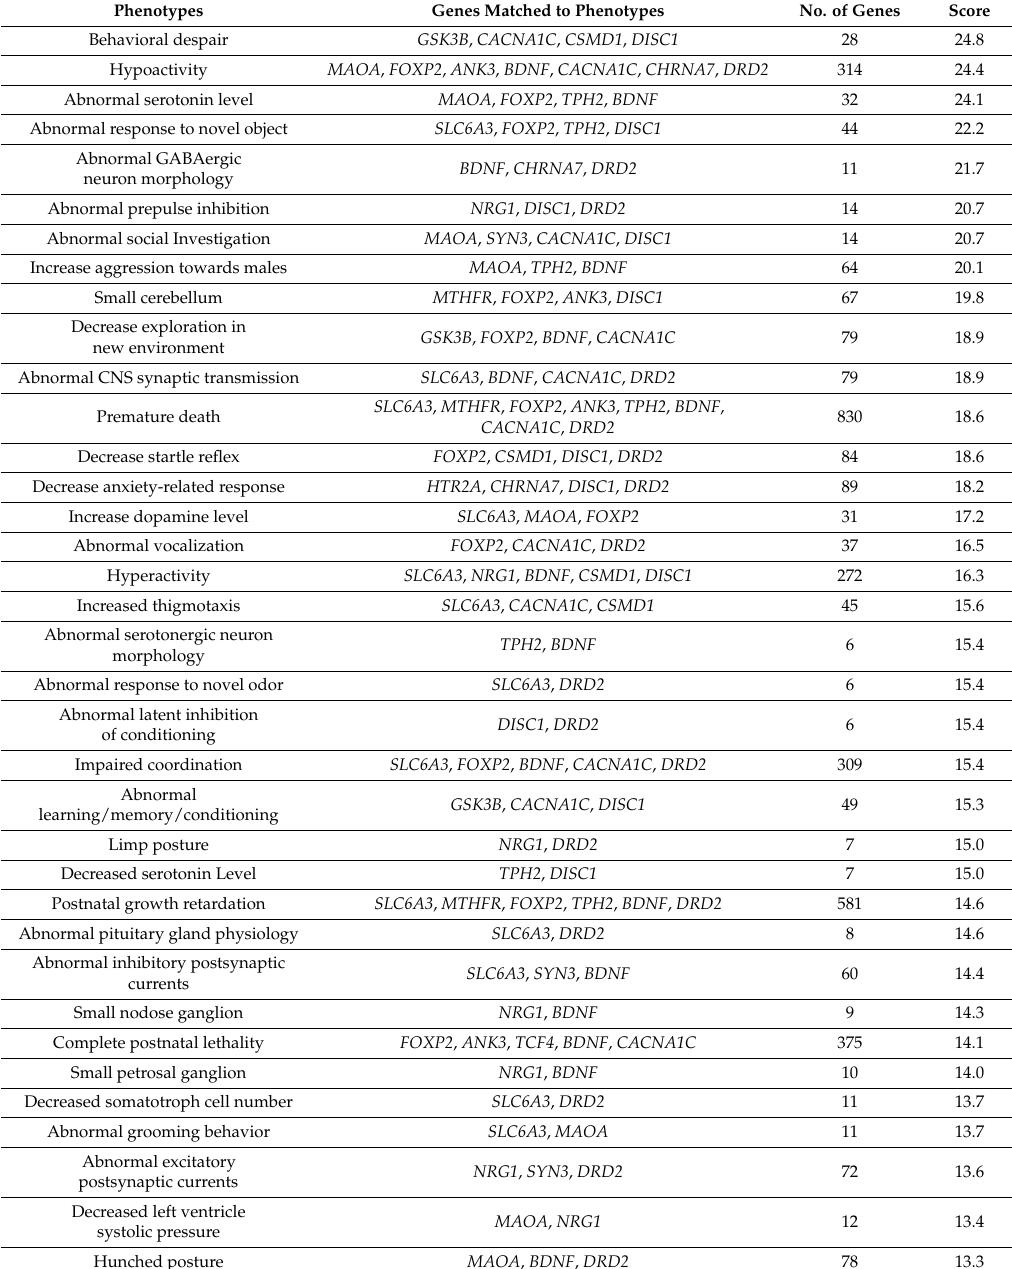
Table 5. GeneAnalytics profiling of high match score phenotypes to 23 overlapping genes for autism spectrum disorder, bipolar disorder and